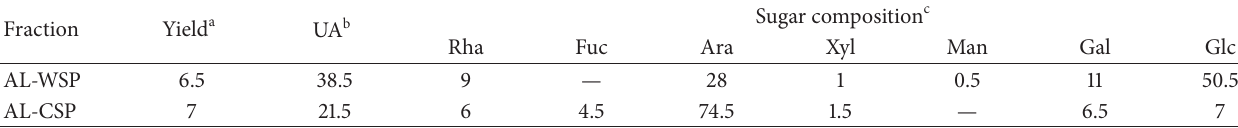
Figure 2: Ion exchange chromatography fractionation of water-soluble (AL-WSP) and chelating-soluble (AL-WSP) pectins. Table 1: Monosaccharide yield and composition of water-soluble AL-WSP and chelating-soluble AL-CSP pectins obtained by gas chromatography